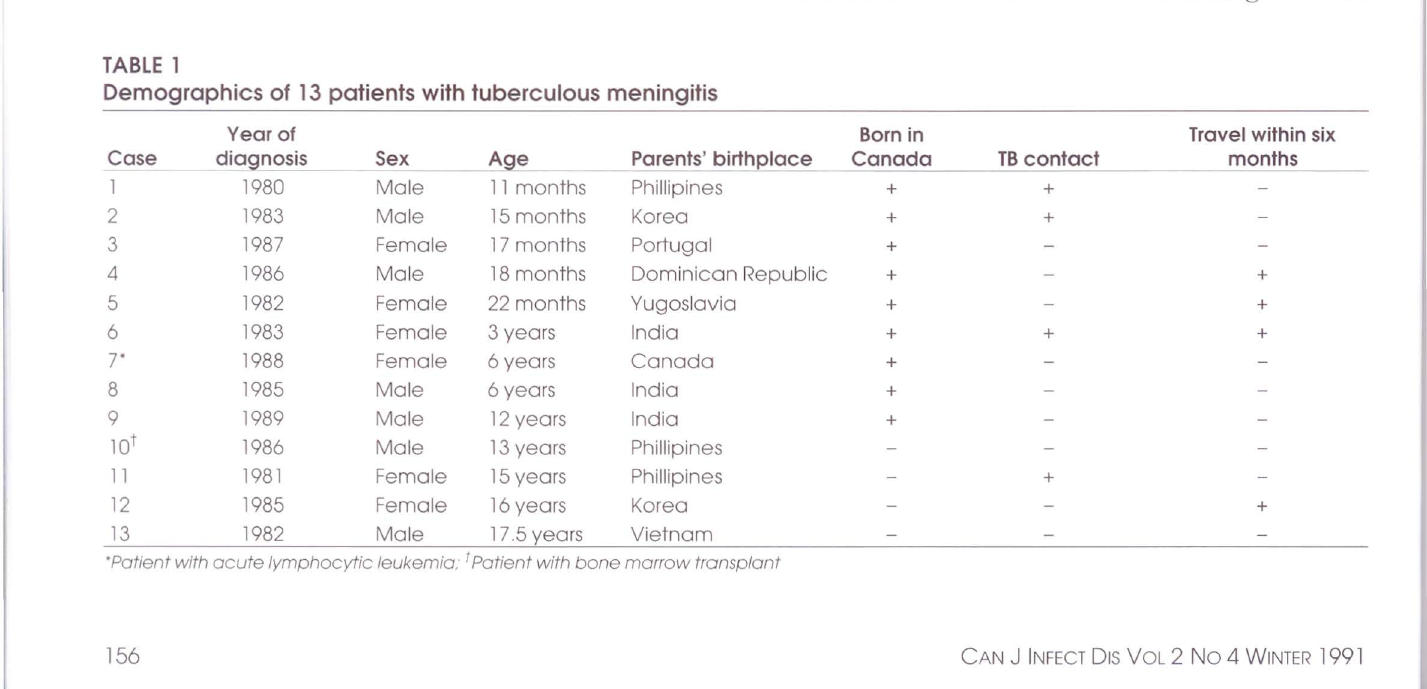
Demographics of 13 patients with tuberculous meningitis Year